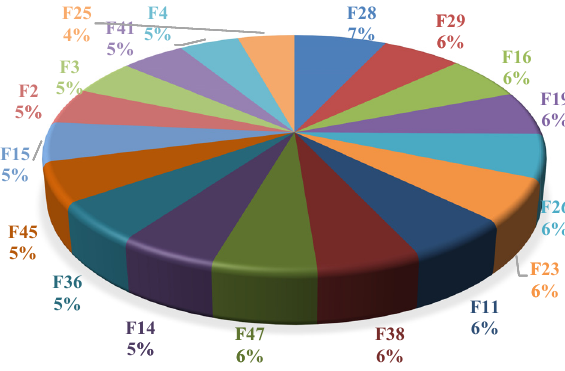
Figure 8: Local impact of factors in the implementation stage.